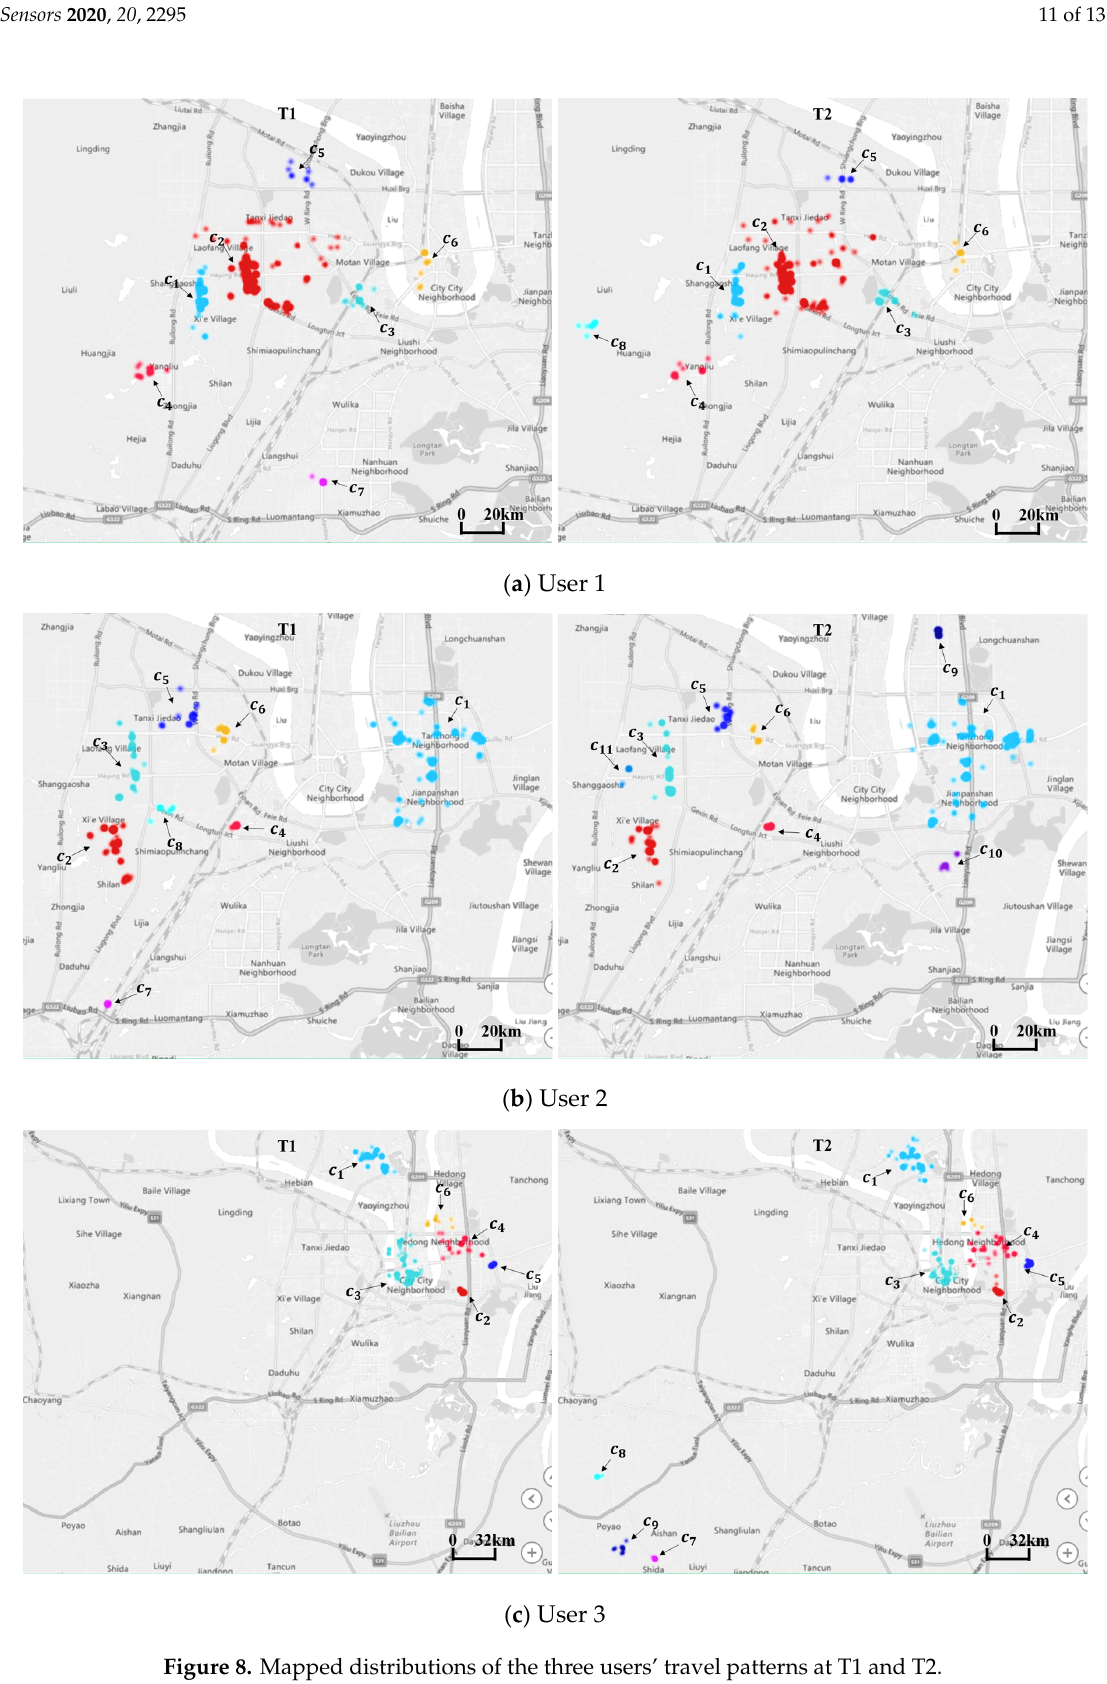
Figure 8. Mapped distributions of the three users’ travel patterns at T1 and T2.